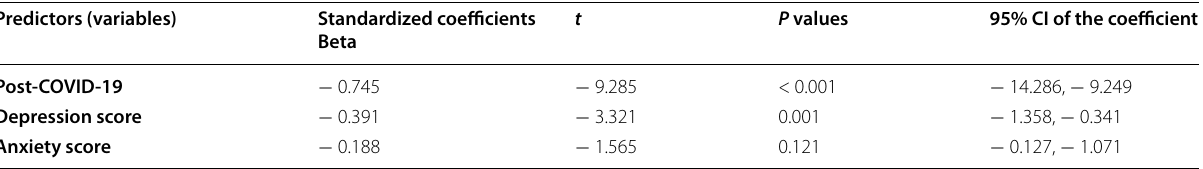
Table 8 Multiple linear regression considering memory variable as an outcome while predictors are post COVID‑19, depression score, and anxiety score